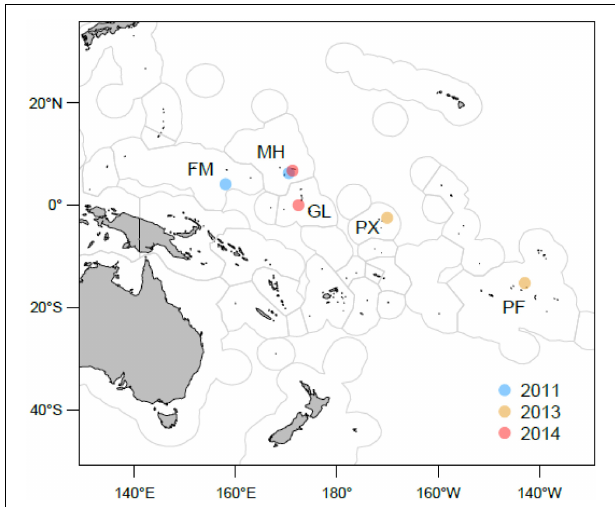
FIGURE 1 | Locations of population samples in the WCPFC area used for genetic comparisons. Circles represent coordinates within 1 ◦ square where samples were collected. Samples of bigeye ( T. obesus ) were obtained by observers in commercial fishing vessels and tagging cruises in the exclusive economic zones (blue contour) of Federated States of Micronesia (FM), French Polynesia (PF), Gilbert (GL) and Phoenix (PX) Islands of Kiribati and Marshall Islands (MH). Color codes refer to the year were samples were collected. This figure was produced by Jed Macdonald from of the Secretariat of the Pacific Community (SPC) using ArcGIS